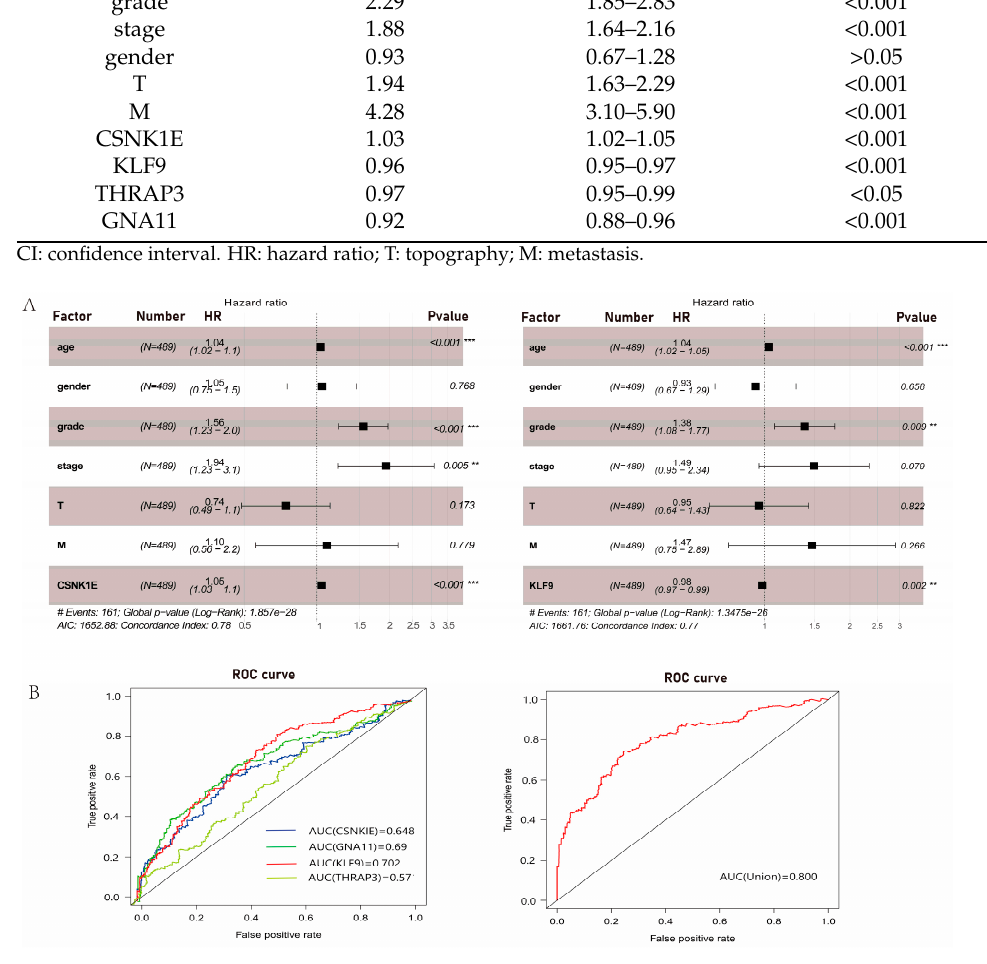
Figure 6. Clinical relevance analyses of DERGs. ( A ) Multivariate Cox analysis of clinical OS in 489 KIRC patients; ( B ) the risk score of ROC curves in KIRC.